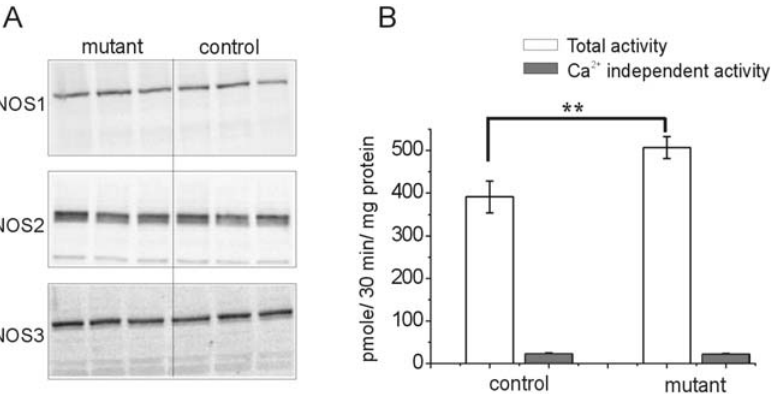
Figure 6. NOS proteins are conserved in the mutant neocortex, but NOS activity is increased. (A) Example of western blot analysis from 3 control and 3 mutant mice neocortex, demonstrating tight conservation of all 3 NOS proteins. (B) The results of NOS radioenzymatic assay reveal an increase in the total NOS activity in mutant mice neocortex (open bars, p=0.01). The Ca 2 + -independent NOS fraction (gray bars) did not differ between the two mice strains. Data from 3 animals of each strain is displayed as mean 6 SD.